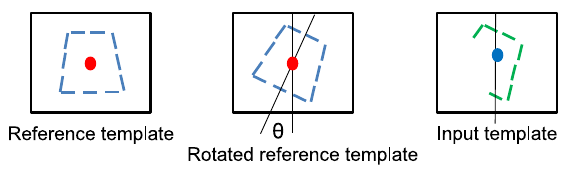
Figure 6: Angular difference among